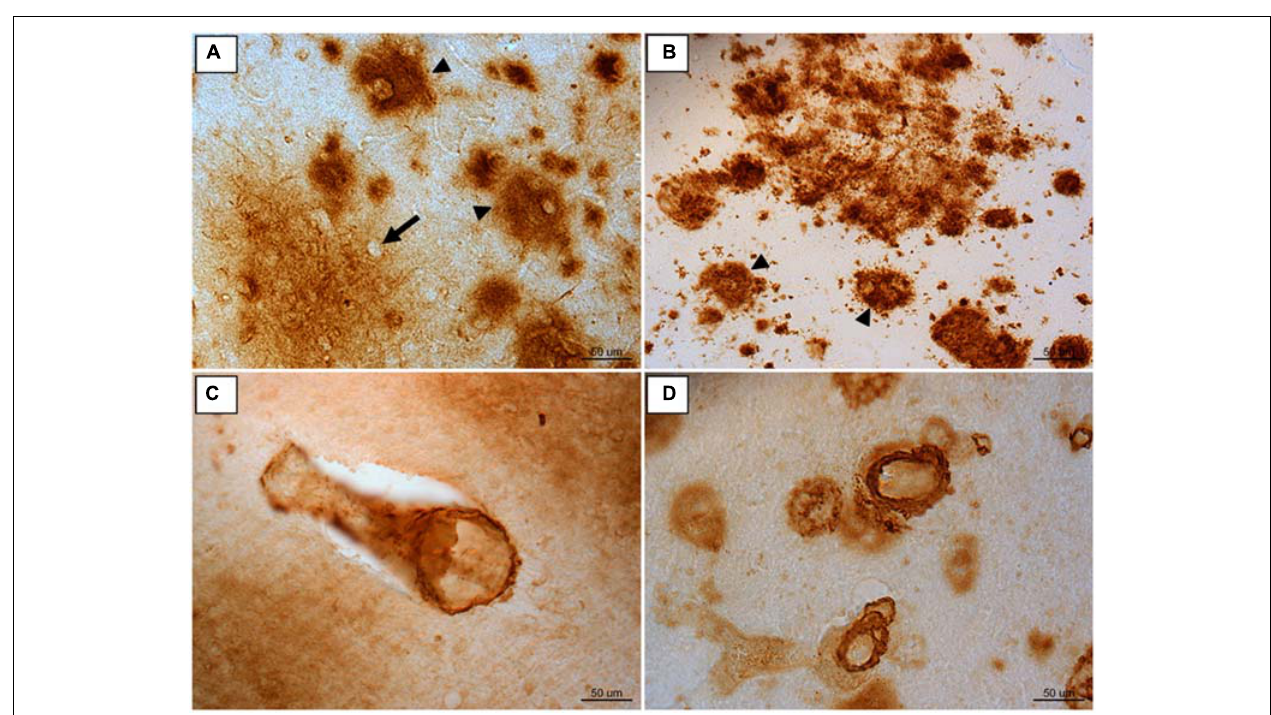
FIGURE 1 | Immunoreactivity forA β 1-42 in frontal cortex brain tissue of (A) an aged canine and (B) an aged human. Compact A β deposits are similar in humans and canines (arrow head).The outline of an intact neuron